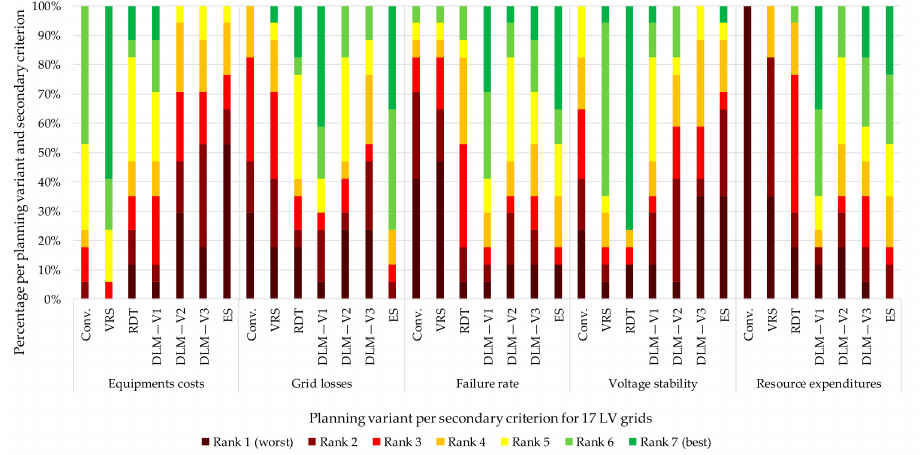
Figure 37. Percentage distribution of the ranking consolidated for 17 low-voltage grids in relation to the individual secondary criteria for the progressive scenario with